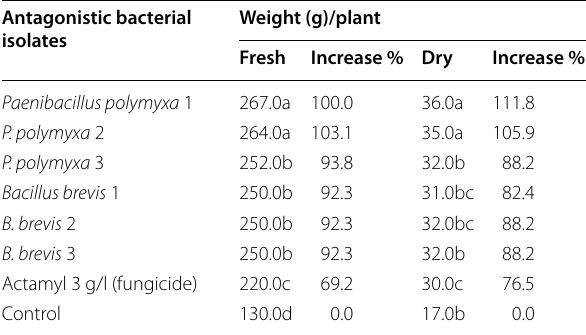
Table 3 Impact of antagonistic bacteria and chemical fungicide on the weight of strawberry plants in the field